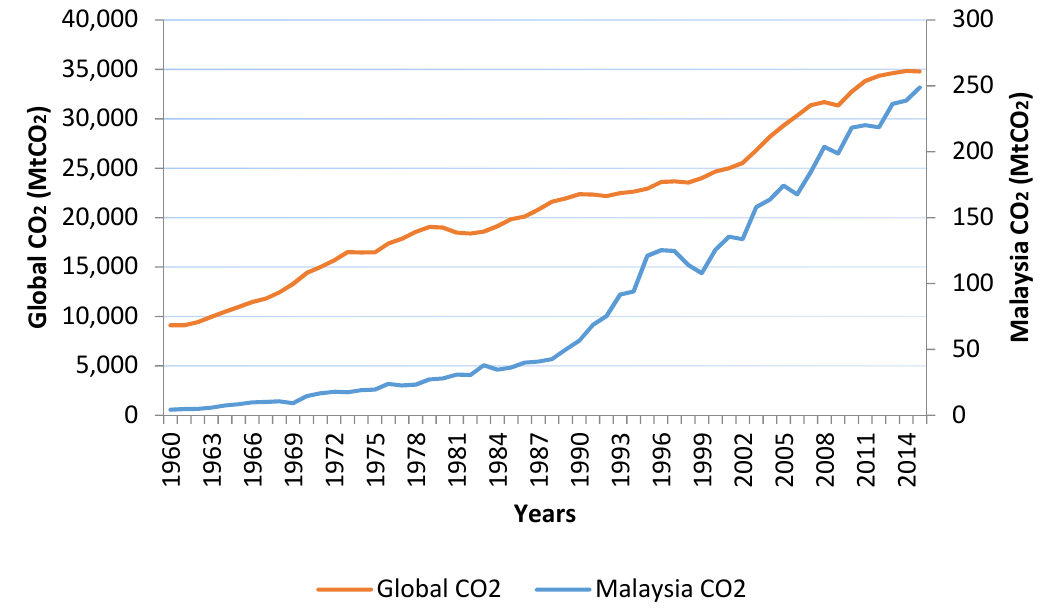
Figure 3. Global and Malaysian carbon dioxide emission from 1960 to 2015 (source: CDIAC, UNFCCC and BP [16]).